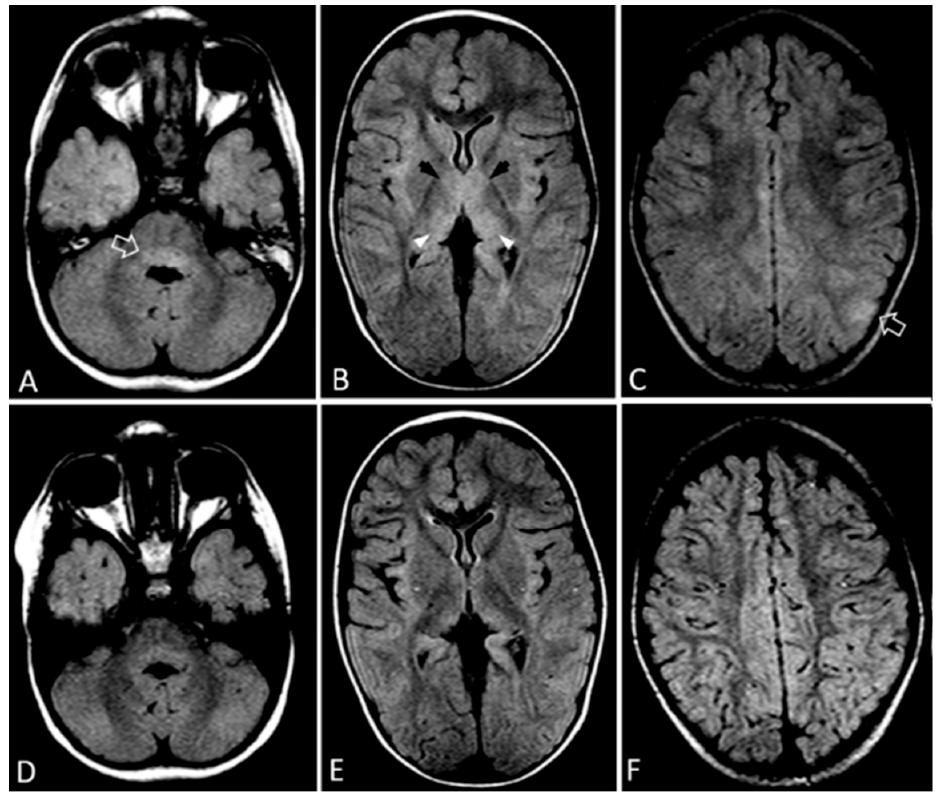
Figure 1. MRI of the brain, FLAIR sequence (TR/TE/FA: 7000/135/150). ( A – C ): Axial images at presentation show hyperintense posterior part of the pons (arrow in ( A )), swollen and hyperintense anteromedial (black arrow) and posteromedial (arrowheads) parts of the thalami in B, as well as a left-sided cortical hyperintensity (arrow in ( C )). ( D – F ): Images at six-month follow-up, same sequence, respective planes, show complete resolution of findings.